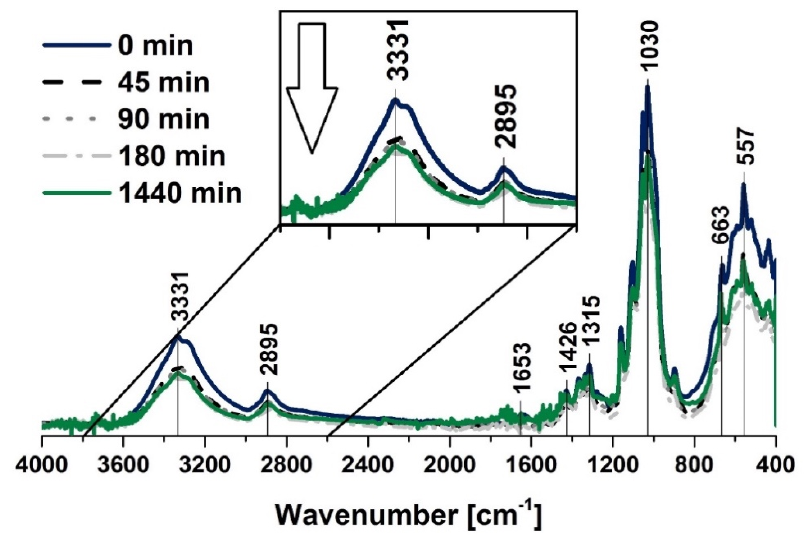
Figure 2. FT-IR spectra of the cellulose fibers that were dried for 1440 min at 100 °C and then left to adsorb moisture for different times. Characteristic absorption bands: 3334 cm − 1 (O–H, water), 2894